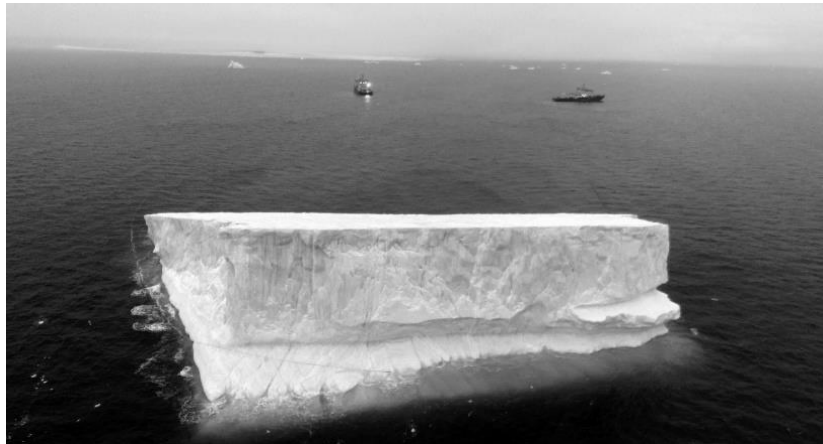
Figure 1. The towing of an over two-million-ton iceberg, using two icebreakers [43].